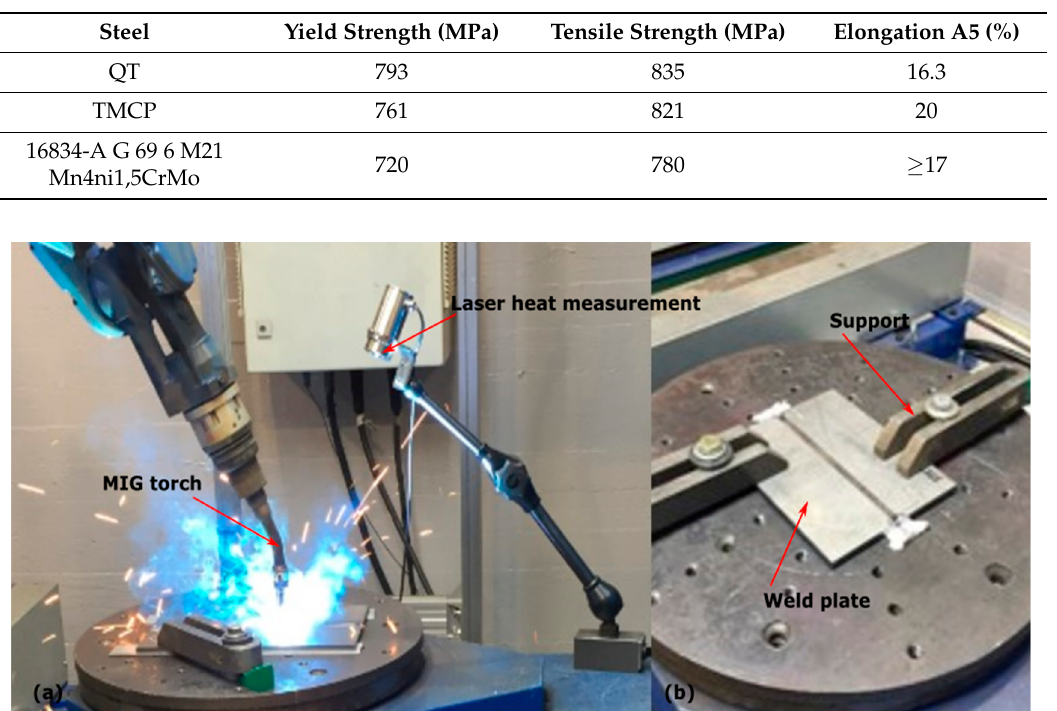
Table 3. Welding conditions.